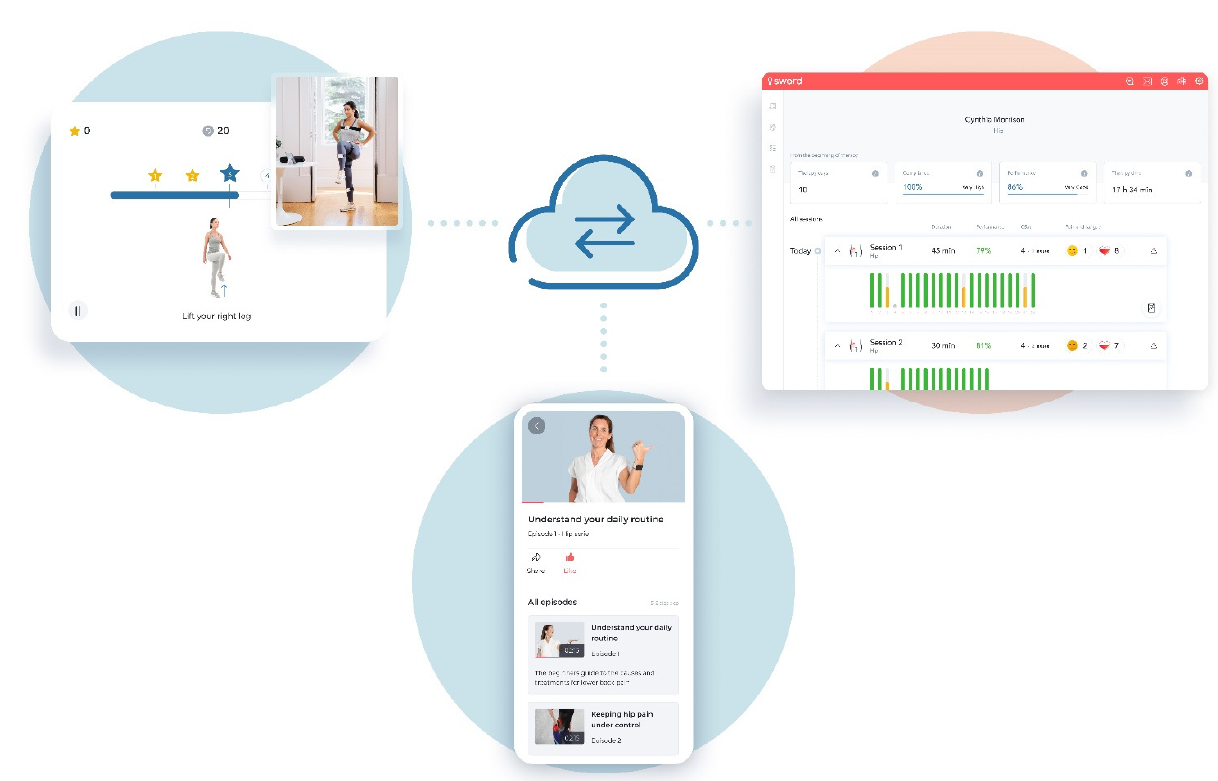
Figure 1. Schematic representation of the intervention. The top-left figure depicts a patient performing a session with motion trackers placed on the body transmitting the sensor data to the cloud. The top-right figure shows the web-based portal with the data of a patient’s sessions which can be assessed by the PT, who can adjust the program as needed. The bottom-center figure shows examples of educational articles on the dedicated smartphone app educating patients about their condition and pain self-management.